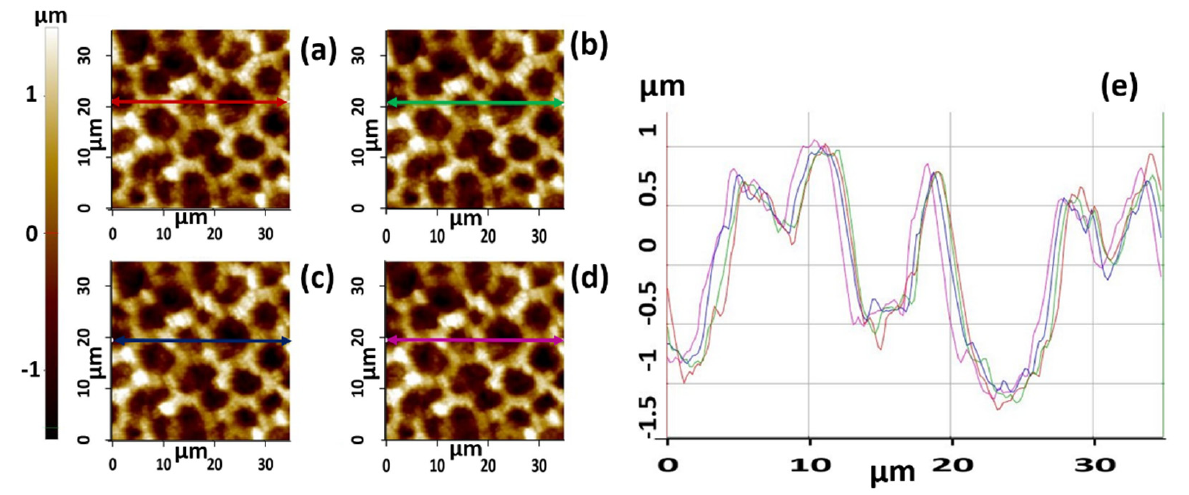
Figure 11. Surface topography of superhydrophobic nanocomposite coating at ( a ) initial state, ( b ) after 1 min of accelerated corrosion, ( c ) after 3 min of accelerated corrosion, ( d ) after 60 min of accelerated corrosion, ( e ) Z–height line analysis .